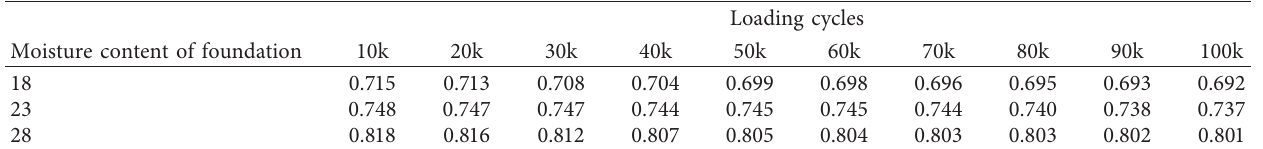
Figure 4: The relationships between stresses and loading cycles at different depths. (a) The moisture content of the foundation was 18%. (b) The moisture content of the foundation was 23%. (c) The moisture content of the foundation was 28%. Table 3: Stress attenuation rate in the test range under different loading